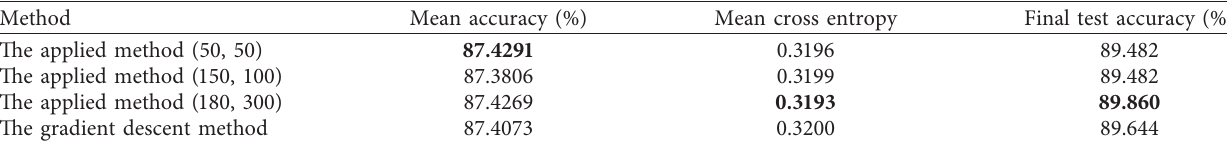
Table 1: Results of the applied method and the gradient descent optimizer for image